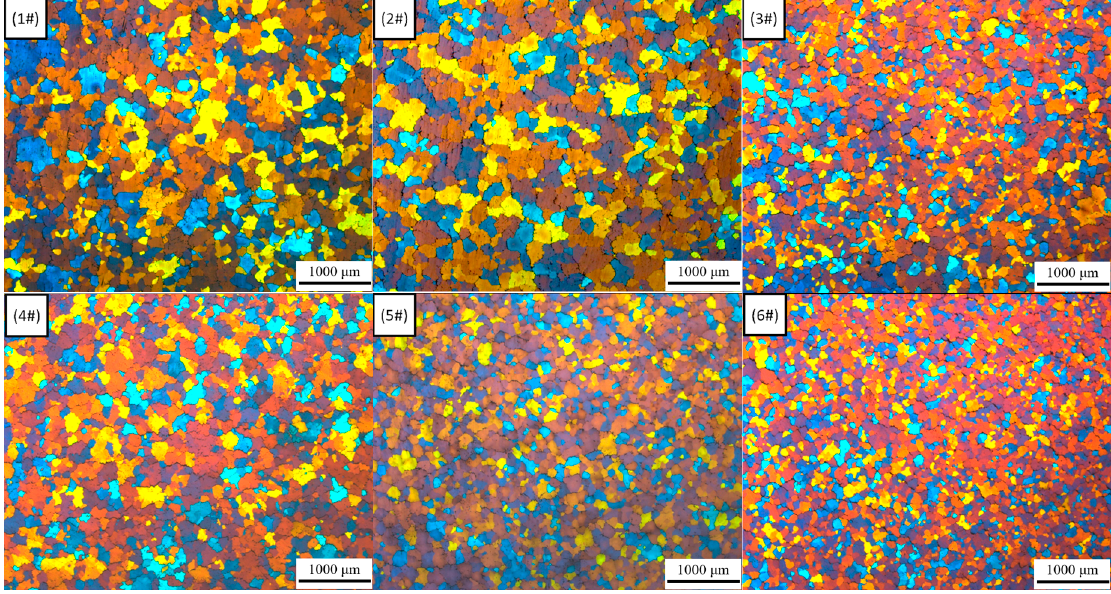
Figure 8. Color metallographic photos 1–6#.